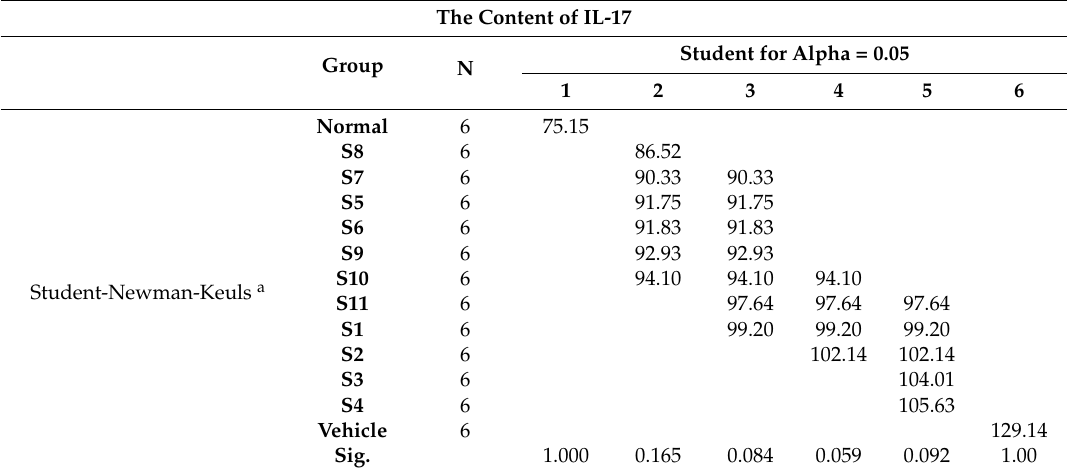
Table 7. Multiple comparison SNK test results of